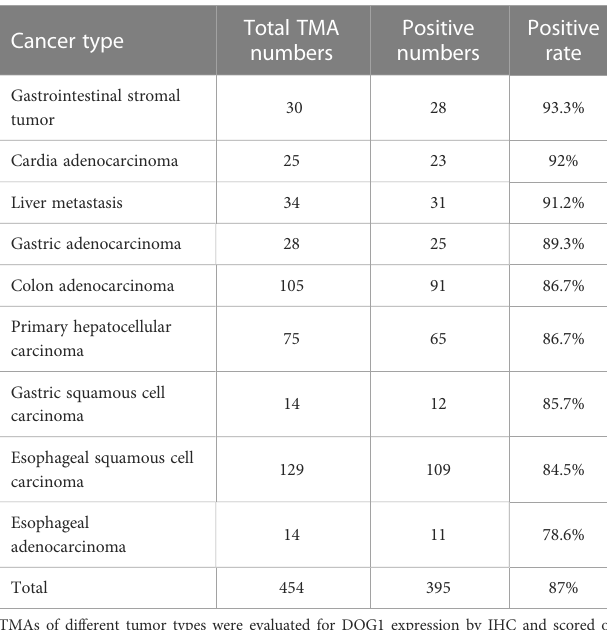
TABLE 1 The positive expression rate of DOG1 in human tumor TMAs.